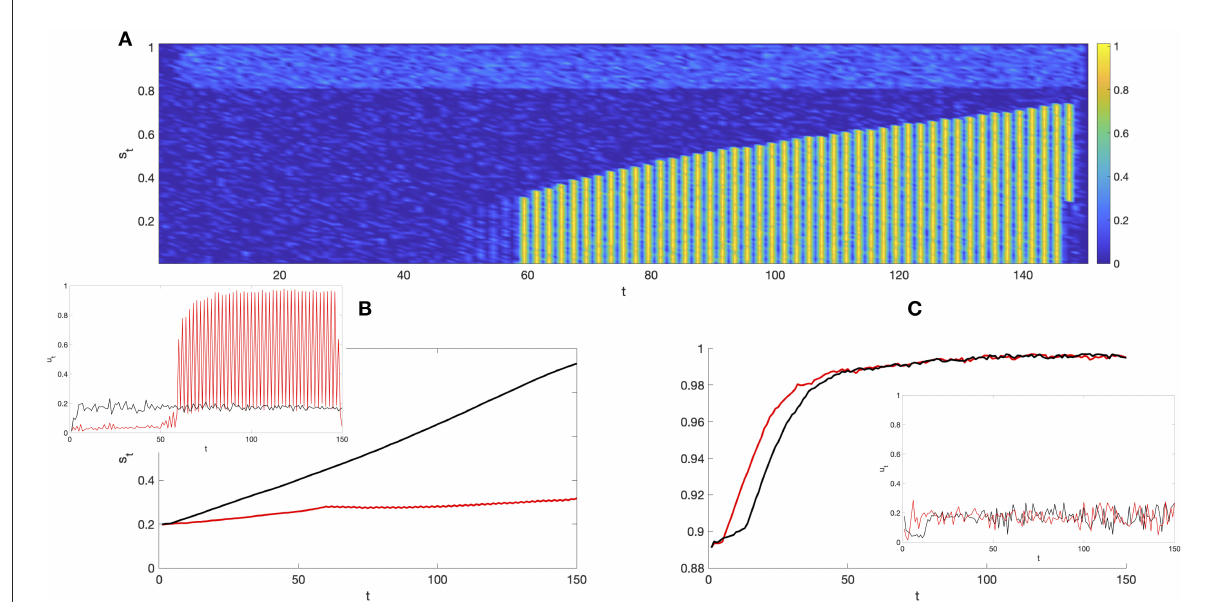
FIGURE8 Intuitive individual with emotions. Now we shall consider an individual with p r = 0.2, analyzing, as before, the trends due to emotion starting from a low initial state. (A, B) analyze the effect of emotions starting low ( s 0 = 0.2). (A) reports the optimal policy whereas (B) demonstrates the state evolution and, in the insert, the effective choice over time. (C) considers a high ( s 0 = 0.9) initial state and shows the state dynamic and, in the insert, the efficient choice. The red line indicates behavior in the presence of emotion whereas the black line in absence of emotion (considering a constant δ = 0.75). In both cases the feedback loop is included, modeling self-aware decisions. The other model parameters are the same used in Figure